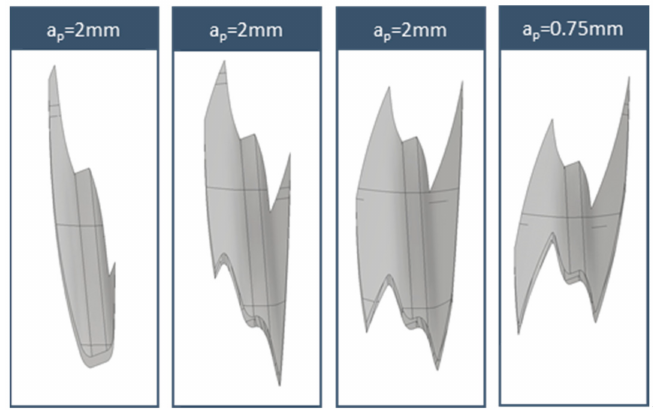
Figure 15. Solid chip geometries for strategy